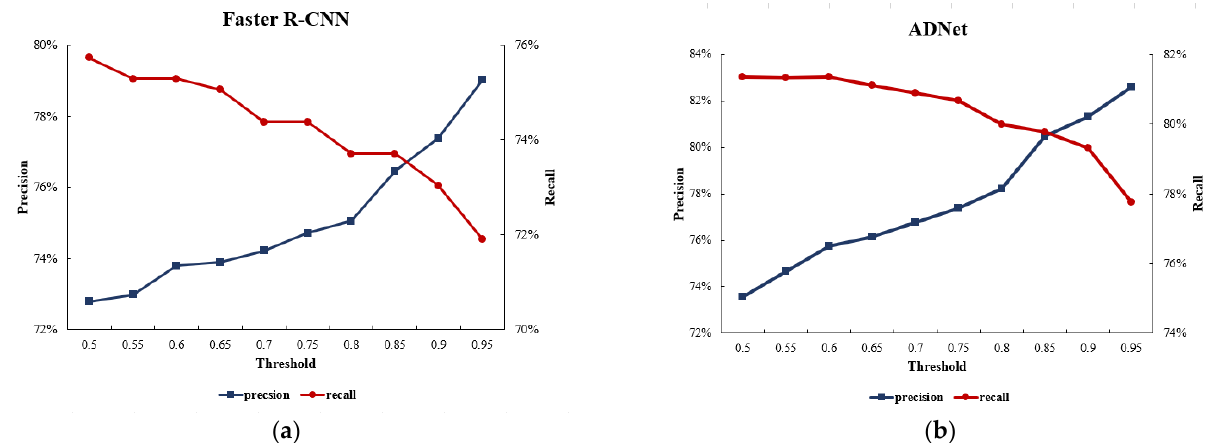
Figure 10. Performance of Faster R-CNN and ADNet: ( a ) precision rate and recall rate of Faster R-CNN at different thresholds; ( b ) precision rate and recall rate of ADNet at different thresholds.